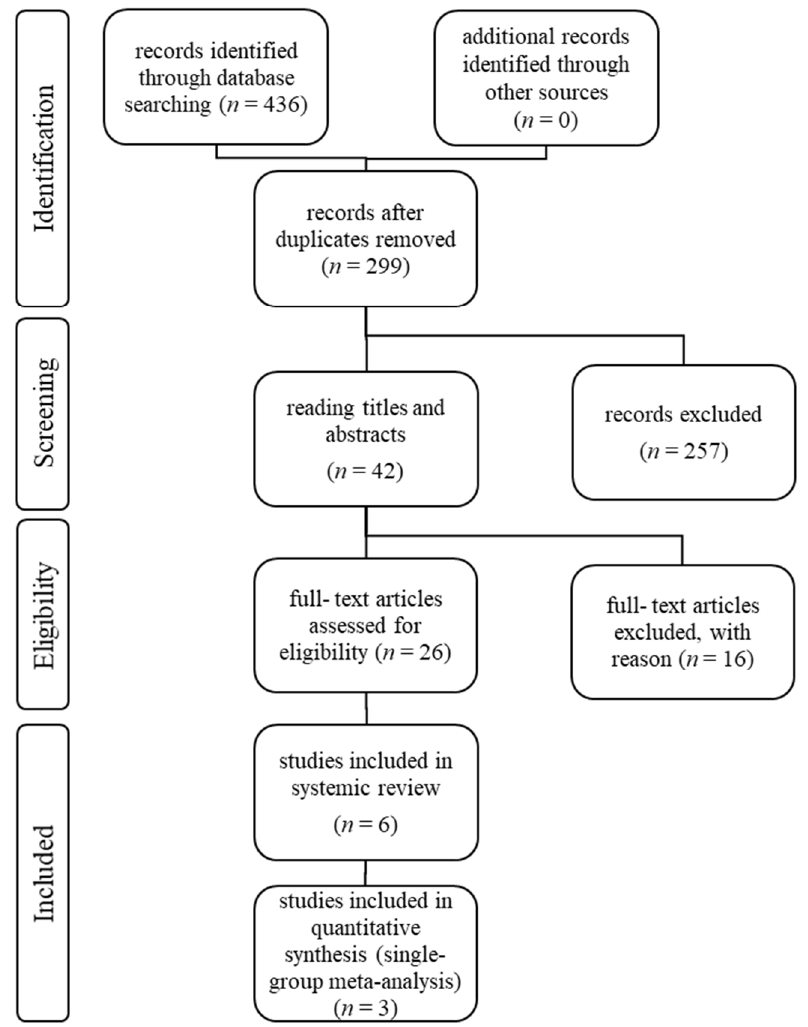
Figure 1. An overview over the study selection following the recommendations of the PRISMA-